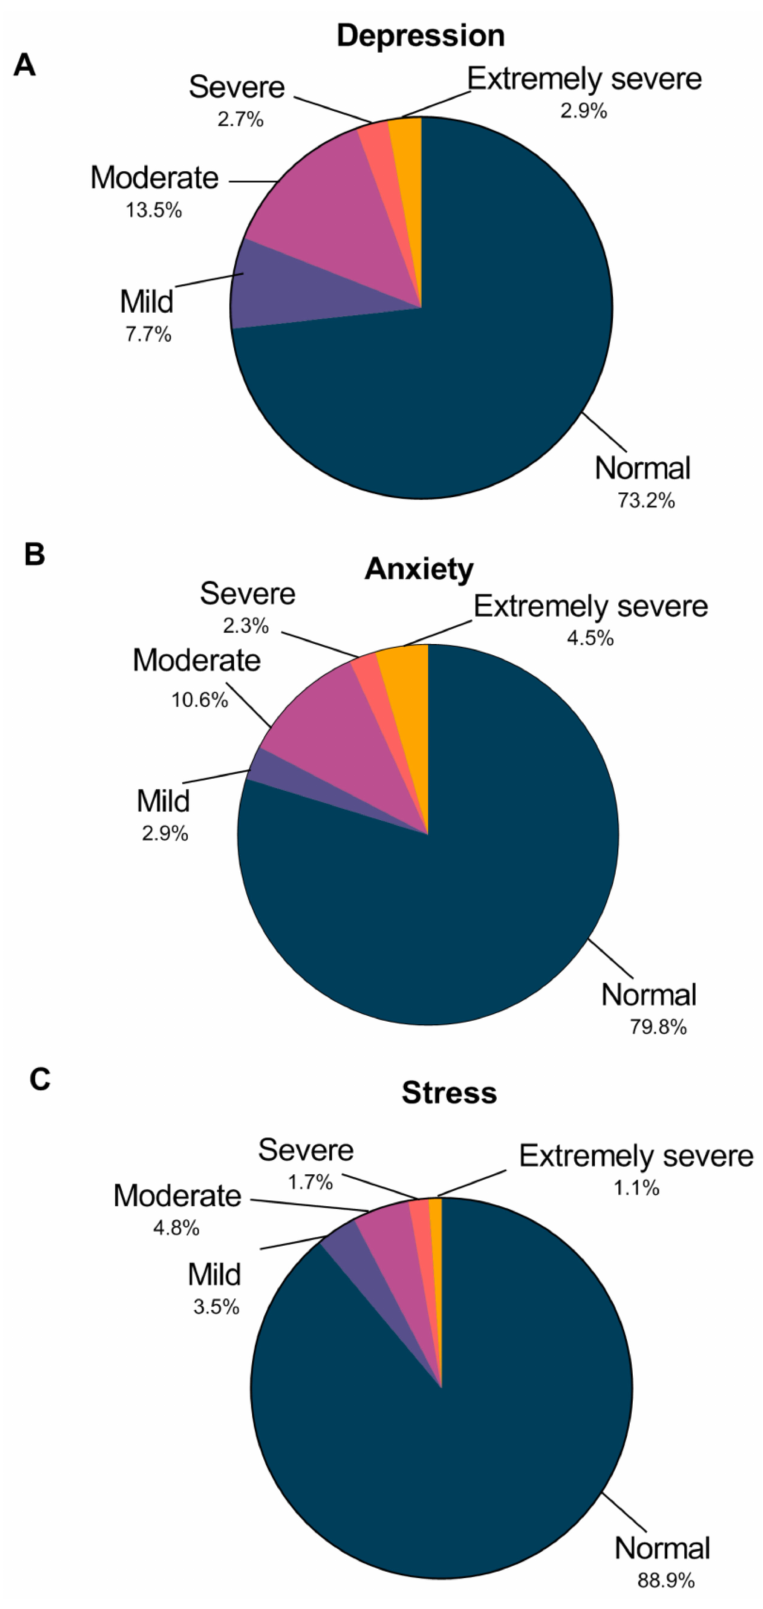
Figure 1. The proportion of participants whose answers on the DASS-21 indicated a normal, mild, moderate, severe or extremely severe amount of depression ( A ), anxiety ( B ), and stress ( C